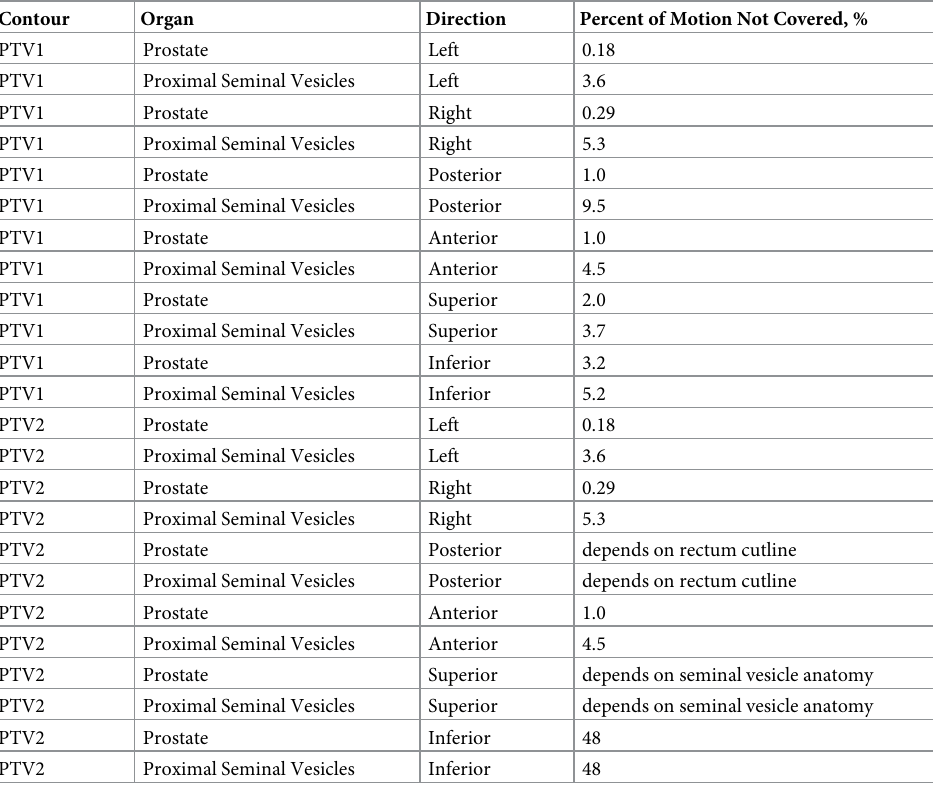
Table 1. Adequacy of target margins to cover interfractional motion as determined from Fig 5. Contour Organ